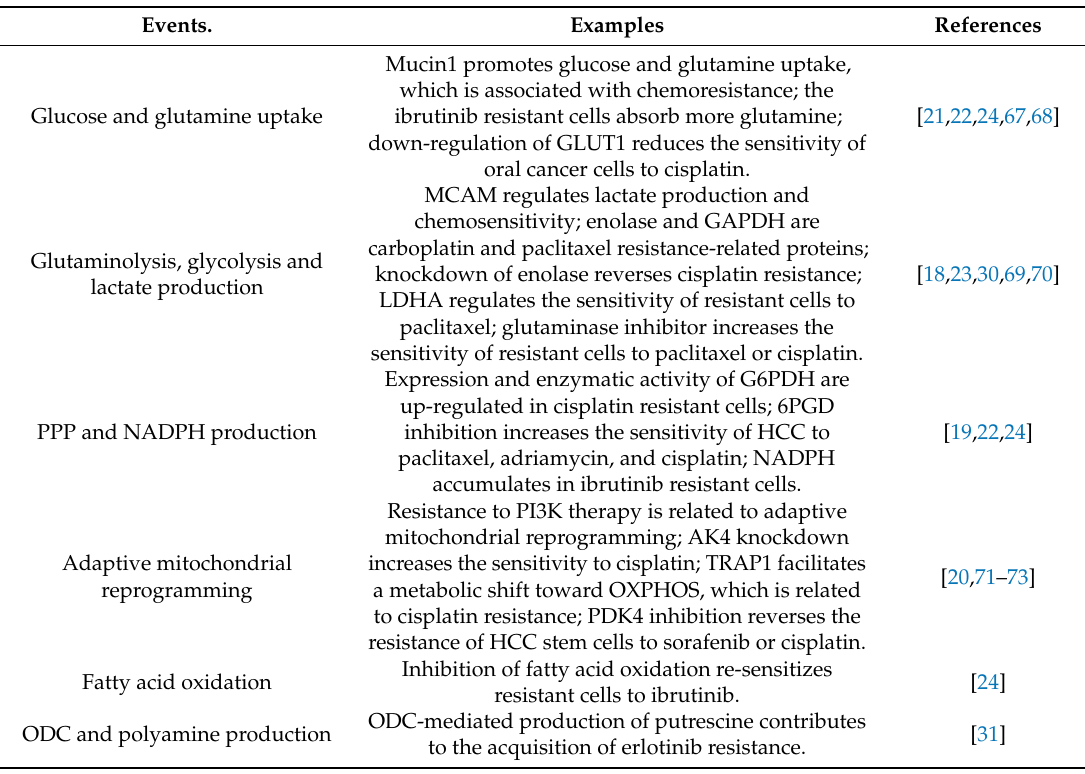
Table 2. Potential metabolic mechanisms of drug resistance.